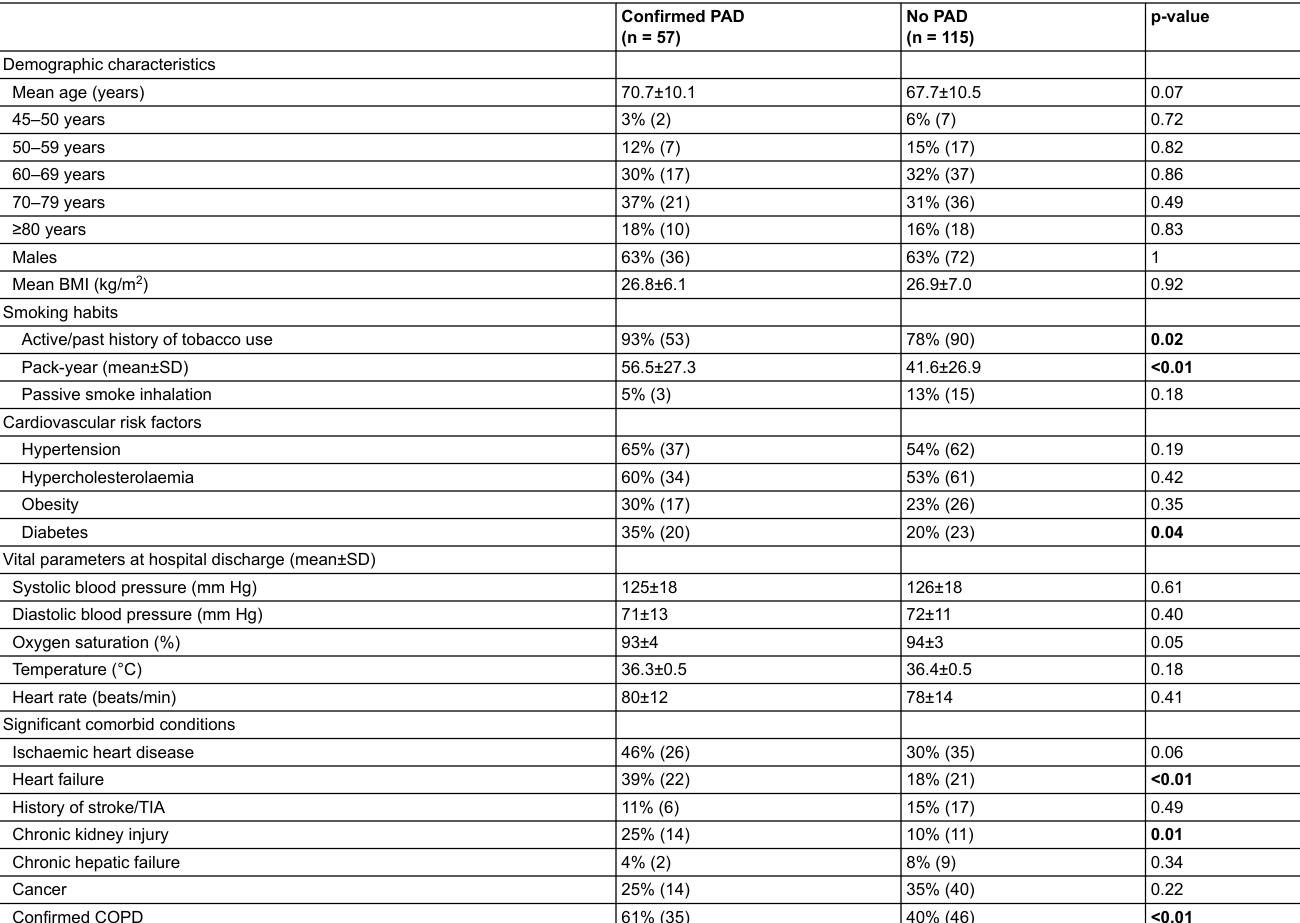
Table 5: Characteristics of patients with confirmed peripheral arterial disease (PAD) vs no PAD.